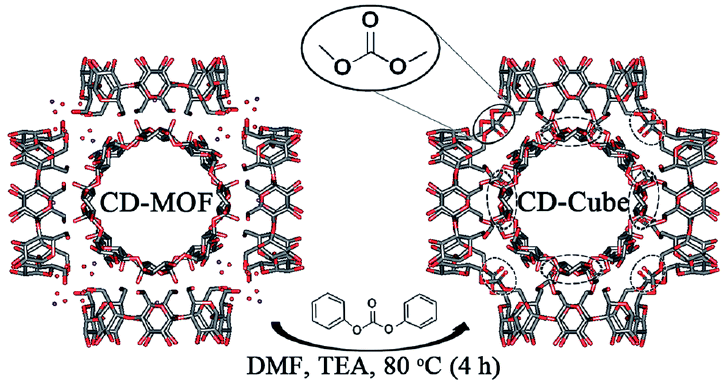
Figure 6. Reaction conditions and structural representation of the formation of a cross-linked cubic gel starting from γ-CD-MOF, depicted for one of its (γ-CD) 6 cubic units and highlighting the kind of chemical links formed. Reproduced from Singh et al . [43] under a Creative Commons Attribution 3.0 Unported Licence (2017).